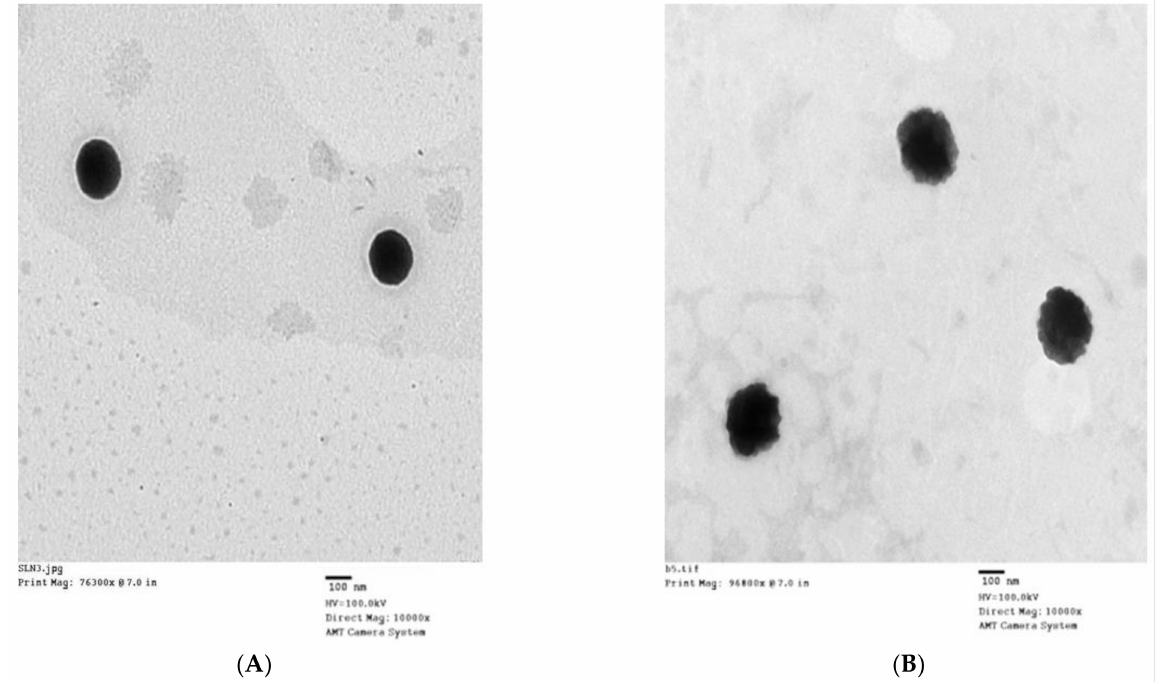
Figure 4. TEM of DRTH (10,000 × ); ( A ) 25 ◦ C; ( B ) 37 ◦